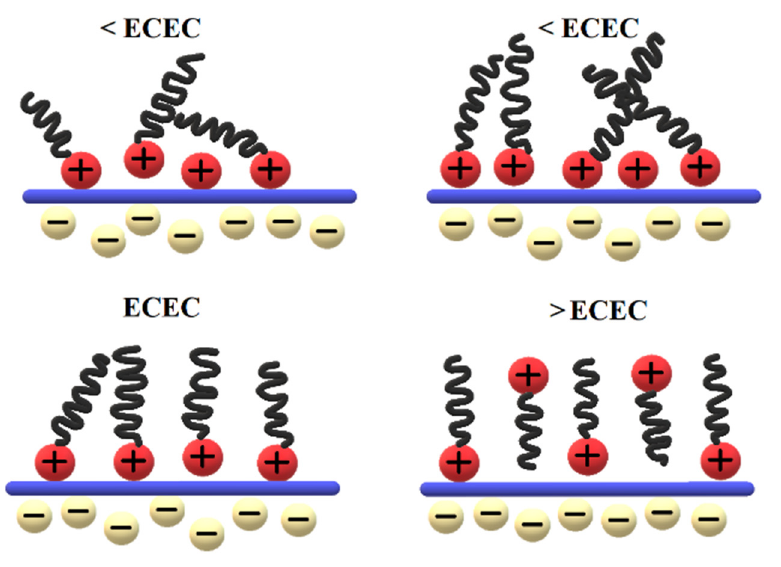
Figure 2. Mechanism of surfactant sorption on the zeolite surface.